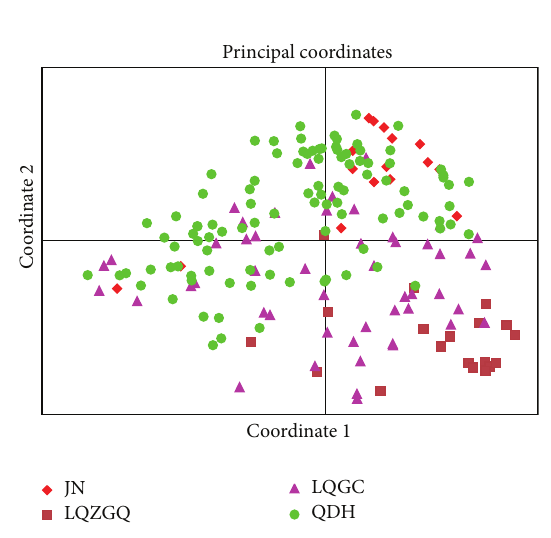
Figure 3: Principal coordinate analysis (PCA) of genetic differences among individuals of four natural populations in O. fragrans